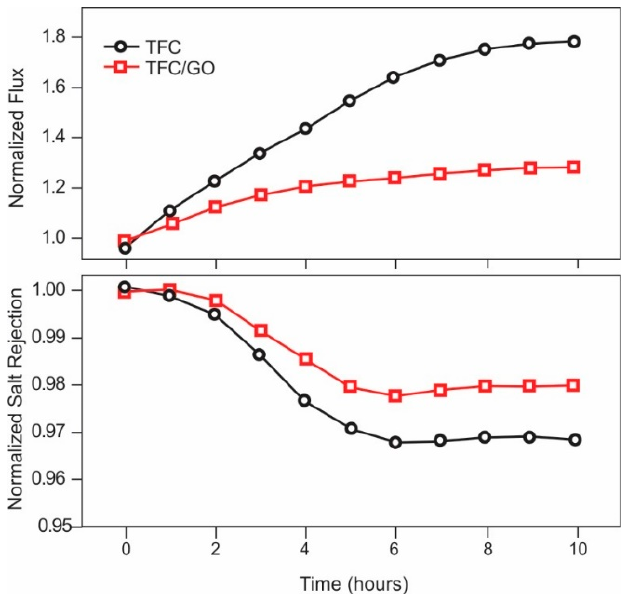
Figure 20. Water flux and salt rejection, normalized to initial performance, for a GO-embedded PA membrane (TFC/GO) and a house-prepared polyamide membrane (TFC) as a function of exposure time to a 500-ppm solution of chlorine. Conditions: 7 bar, 20 °C, pH = 7.0, and 2000 ppm NaCl [287]. Reprinted with permission of Elsevier B.V.